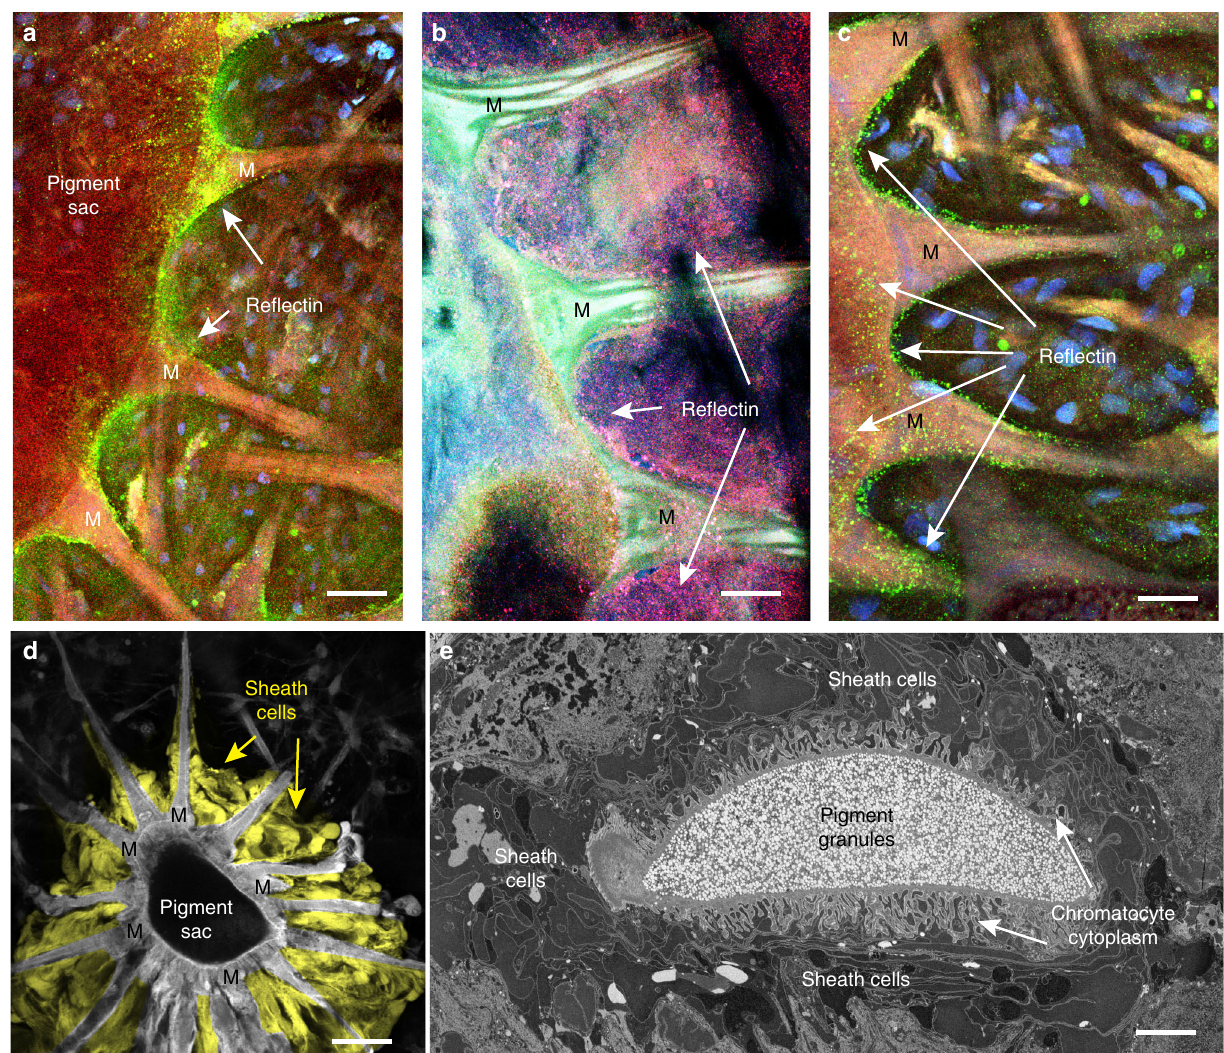
Fig. 5 Anatomical localization of re fl ectin to sheath cells. a Re fl ectin (confocal, secondary antibody in green, arrows) was present surrounding the edge of the chromatocyte and the apical portions of the radial muscles (M). Scale bar is 50 µ m; b Re fl ectin (confocal, dual secondary antibodies in lavender; 405 nm and 568 nm fl uorophores were applied simultaneously to reduce the potential ambiguity associated with auto fl uorescence of the tissue) often extended into the spaces between adjacent apical radial muscles. Scale bar is 25 µ m; c Re fl ectin distribution was frequently punctate, and in addition to coating the muscles and the edge of the chromatocyte, re fl ectin was also present over its surface. Note that the chromatocyte section was very thin (in comparison with the confocal depth of fi eld of the 0.45 NA x20 objective used here), but the label consistently showed on its outside, rather than within